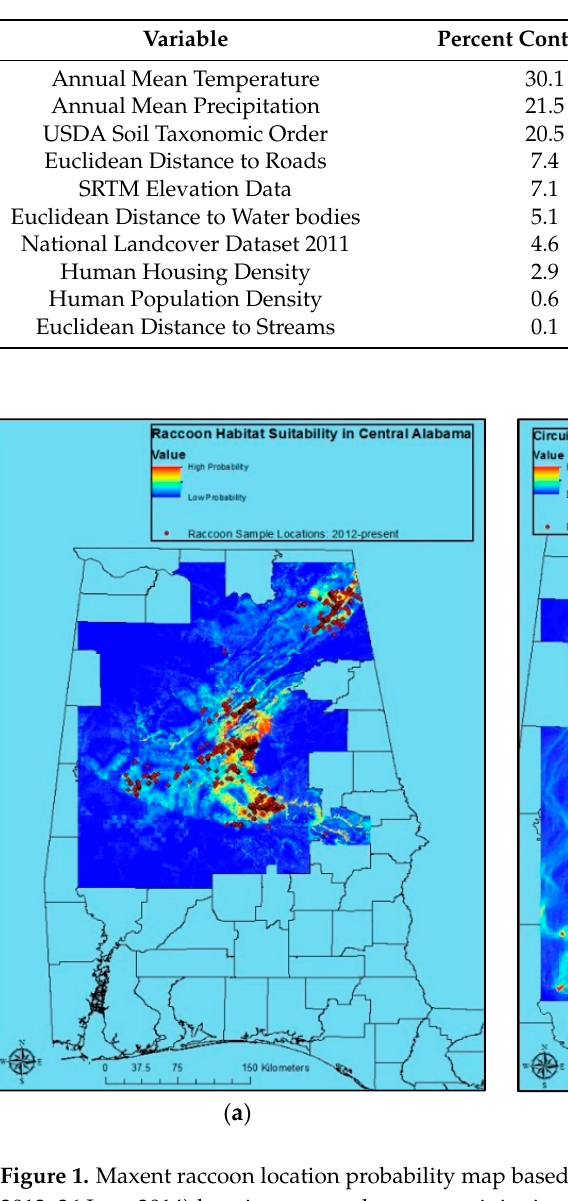
Table 5. Raccoon ( n = 431) risk modeling sample data for pine-dominated landscapes of Florida during 5